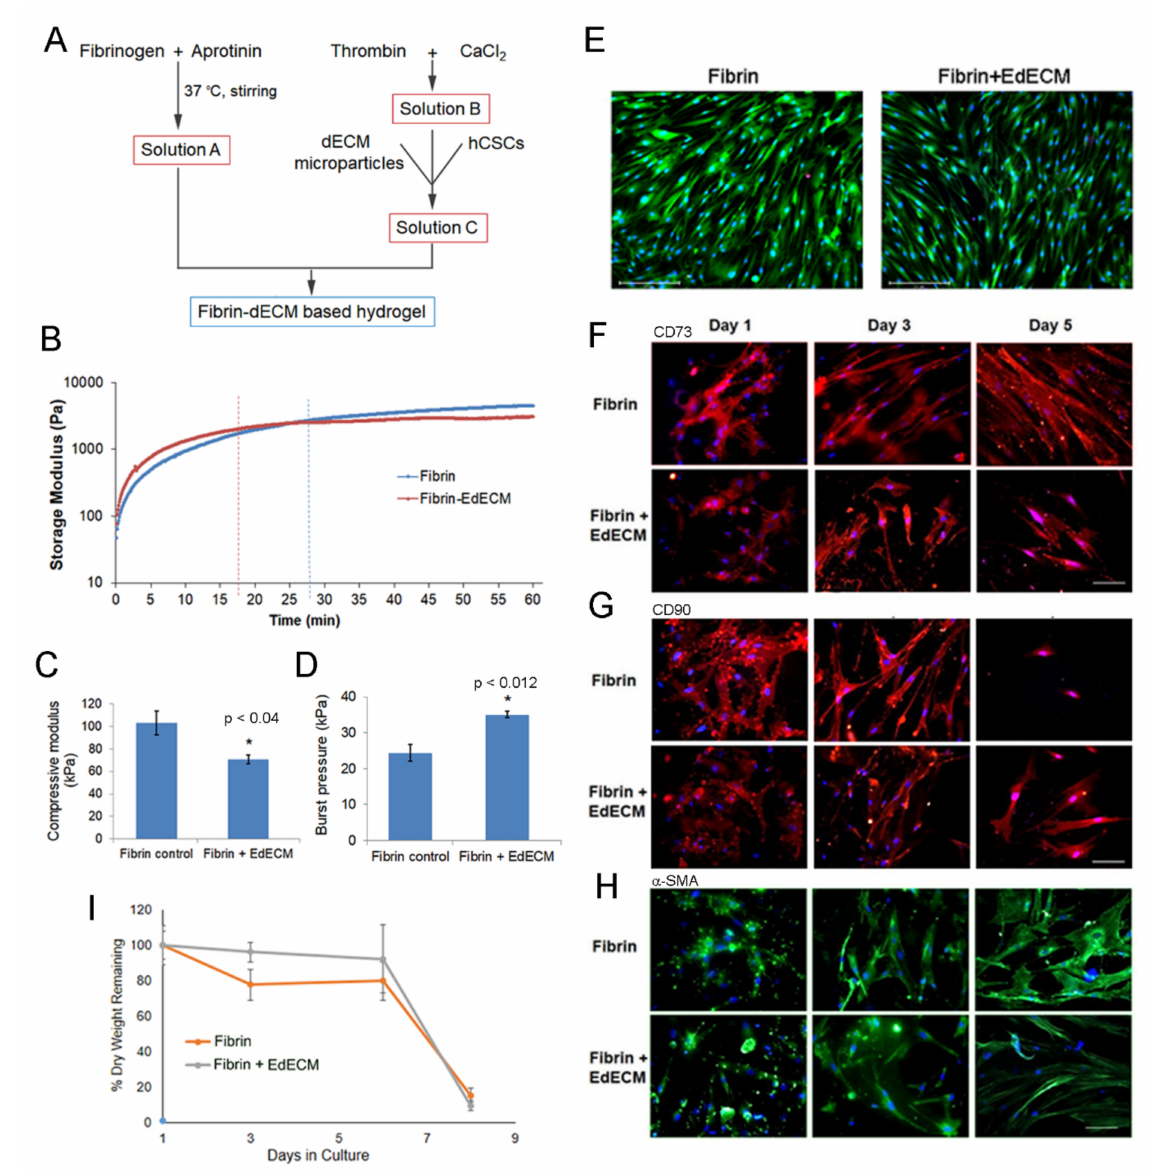
Figure 3. Characterization of fibrin–EdECM based hydrogels: ( A ) schematic for the preparation of fibrin–dECM based hydrogels; ( B ) crosslinking kinetics of fibrin and fibrin–EdECM hydrogels; ( C ) compressive modulus of fibrin and fibrin– EdECM hydrogels; ( D ) maximum burst pressure of fibrin and fibrin–EdECM hydrogels; ( E ) cell viability of hCSCs encapsulated in fibrin and fibrin–EdECM hydrogel on Day 5 via live/dead stain, where reen denotes live cells and red denotes dead cells and nuclei are labeled blue; ( F , G ) CD73 and CD90 biomarker expression of hCSCs encapsulated in fibrin and fibrin–EdECM hydrogels; ( H ) expression of α -SMA in hCSCs encapsulated in fibrin and fibrin–EdECM hydrogels; and ( I ) biodegradation of hCSC encapsulated fibrin and fibrin–EdECM hydrogels in vitro. Data are represented as mean ± SE with n ≥ 3 samples/group. * p ≤ 0.05 denotes significant differences observed between fibrin and fibrin–EdECM